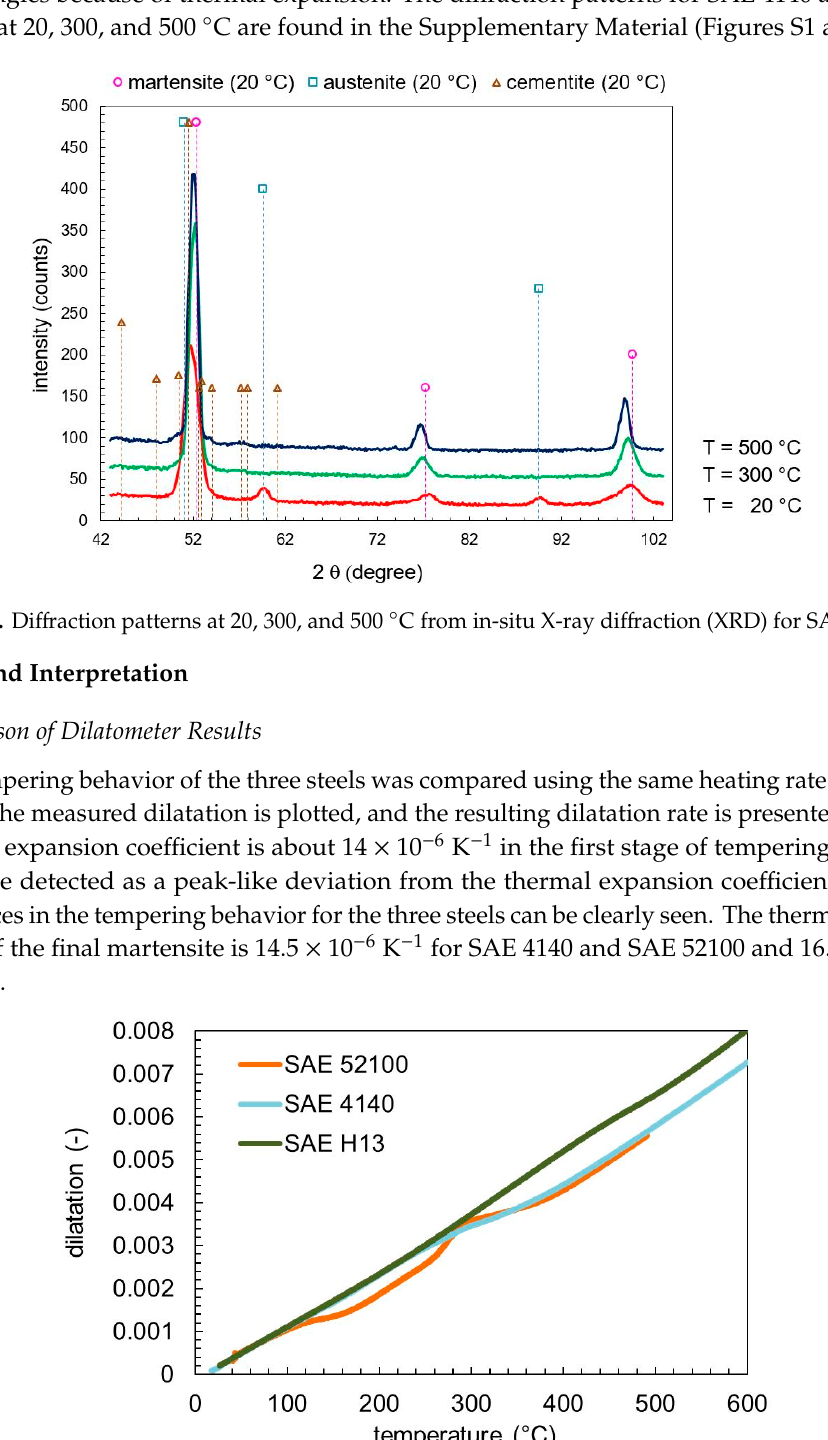
Figure 3. Measured dilatation for the three used steels tempered with a heating rate of 5 K min − 1 .